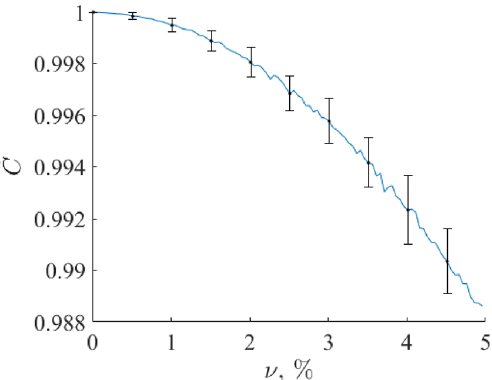
Figure 8. Dependence of the target component (blood) volume fraction restoration error on the additive noise amplitude ν . Here, the true volume fraction value is equal to